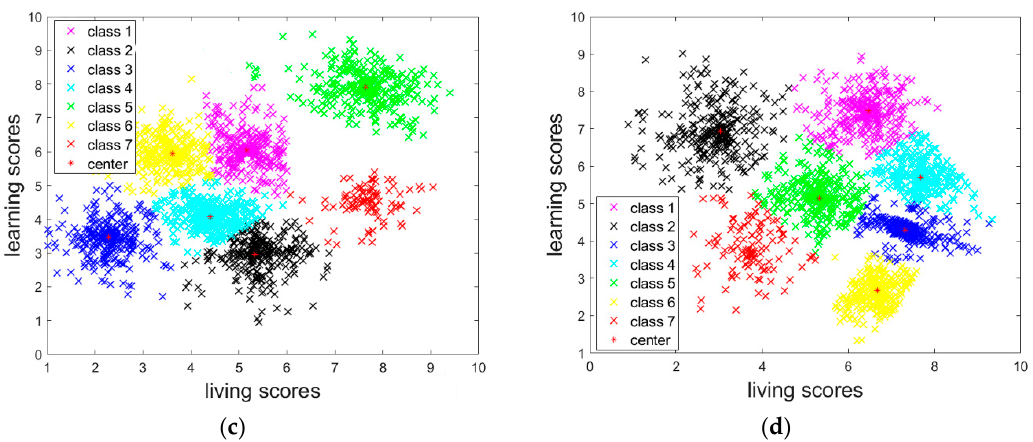
Figure 12. The results graph of K-CFSFDP: ( a ) S1; ( b ) S2; ( c ) S3; and ( d ) S4.